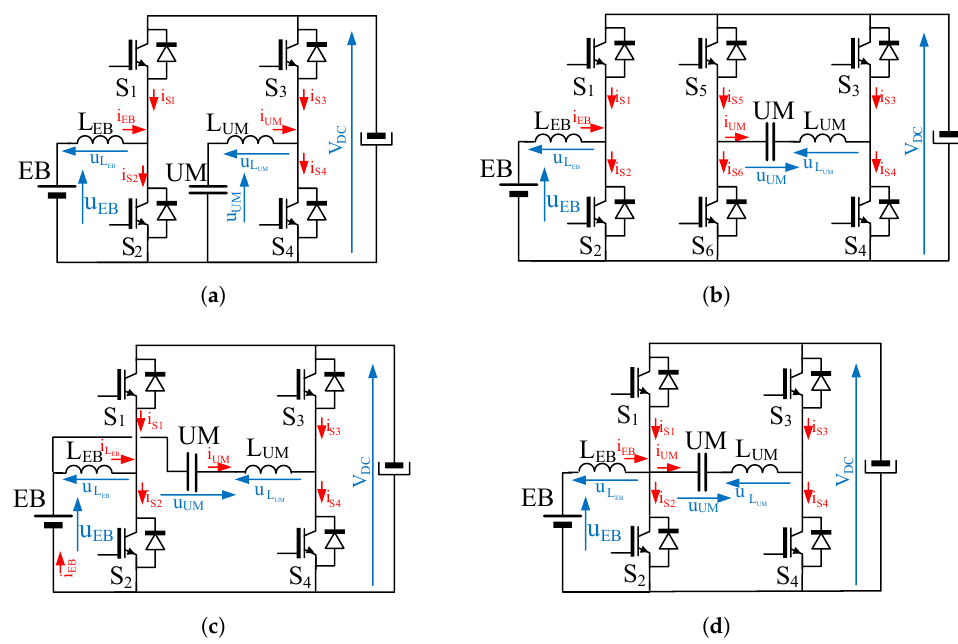
Figure 2. Non-isolated topologies considered for the HSS: ( a ) Direct Parallel Connection (DPC); ( b ) Full-Bridge Connection (FBC); ( c ) Series Connection (SC); and ( d ) Series-Parallel Connection